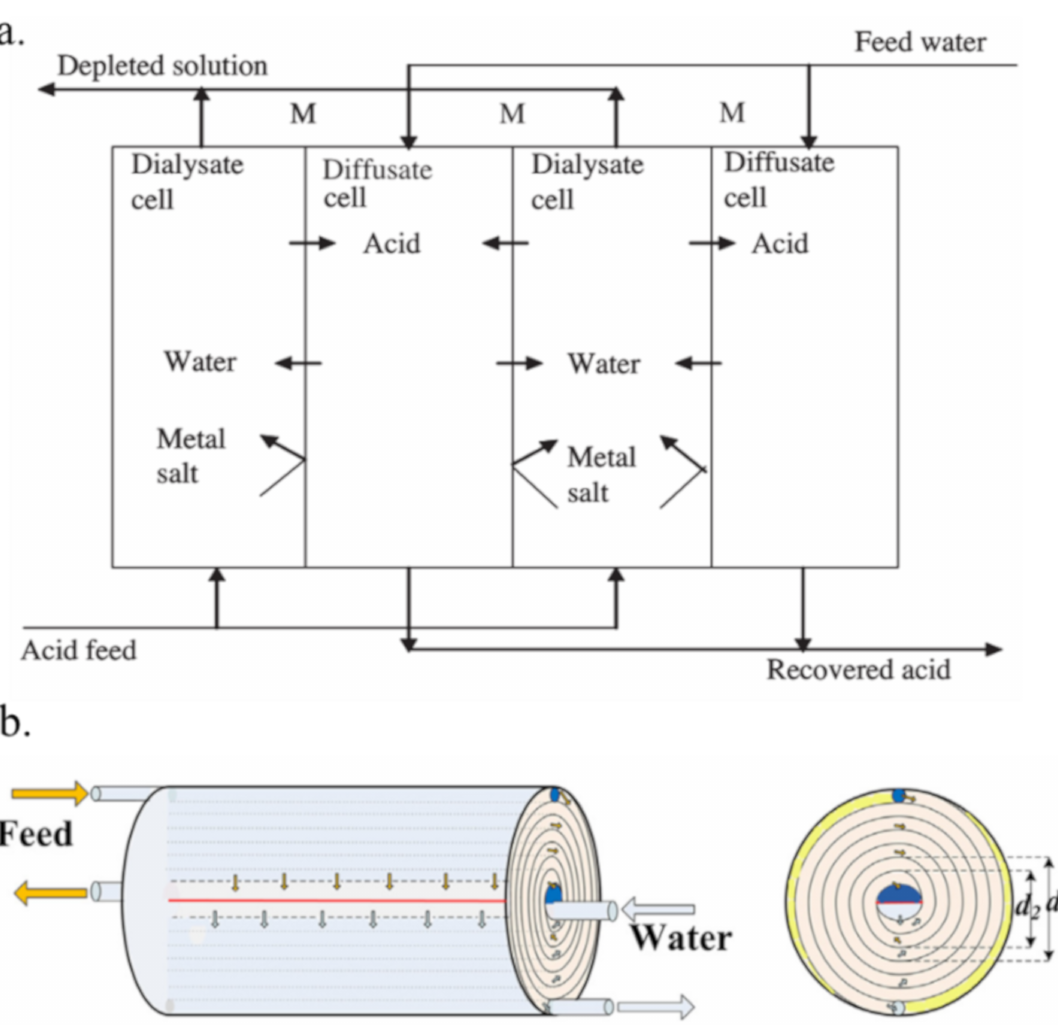
Figure 10. Scheme of Plate-and-frame di ff usion dialysis (PFDD) module ( a ) and spiral wound di ff usion dialysis (SWDD) module ( b )